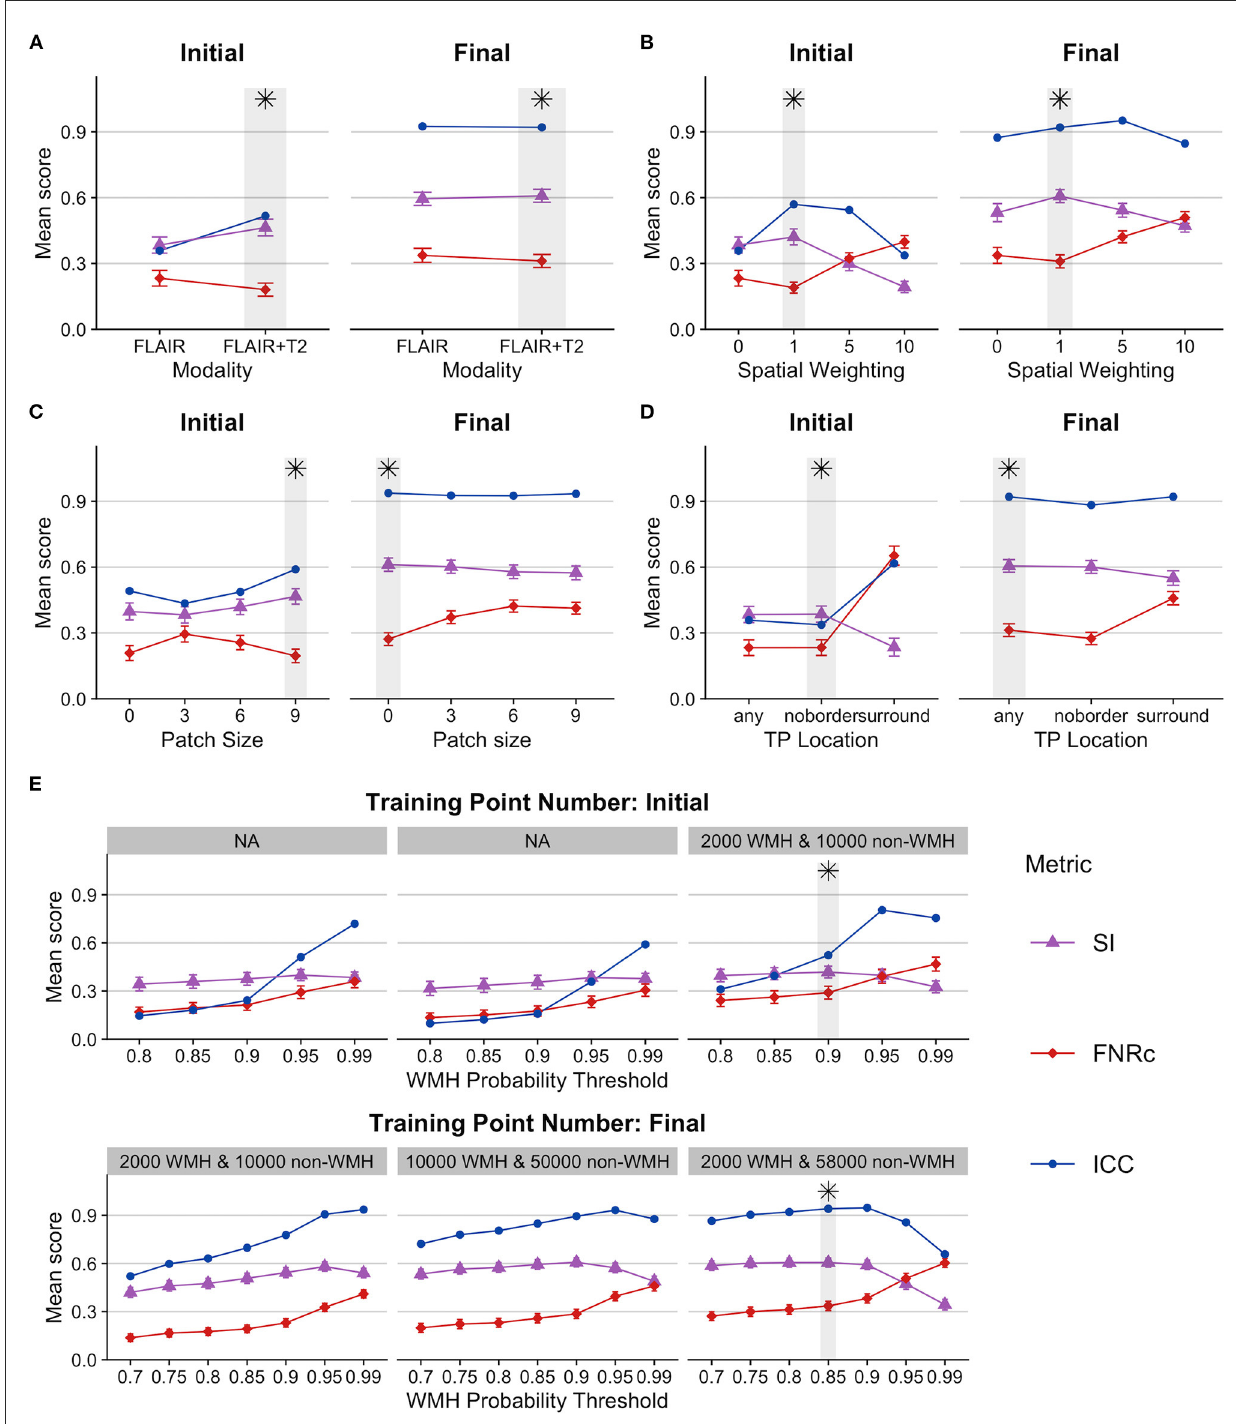
FIGURE1 BIANCA parameter optimization. Figures present BIANCA model scoring for user-defined BIANCA settings tested in the initial and final rounds of BIANCA setting testing. BIANCA performance was scored against gold-standard WMH-masks with the dice similarity index (SI), false-negative ratio by cluster (FNRc), and interclass-correlation coefficient (ICC). Y-axis values are the mean scores for the corresponding scoring metrics. Gray bars and black asterisks indicate the best-performing setting for each BIANCA option. (A–E) BIANCA options, see methods “BIANCA Optimization” section for full description of each option [corresponding to tested options (A–E) ]. For full performance scores from all rounds of BIANCA optimization, see Supplementary Tables